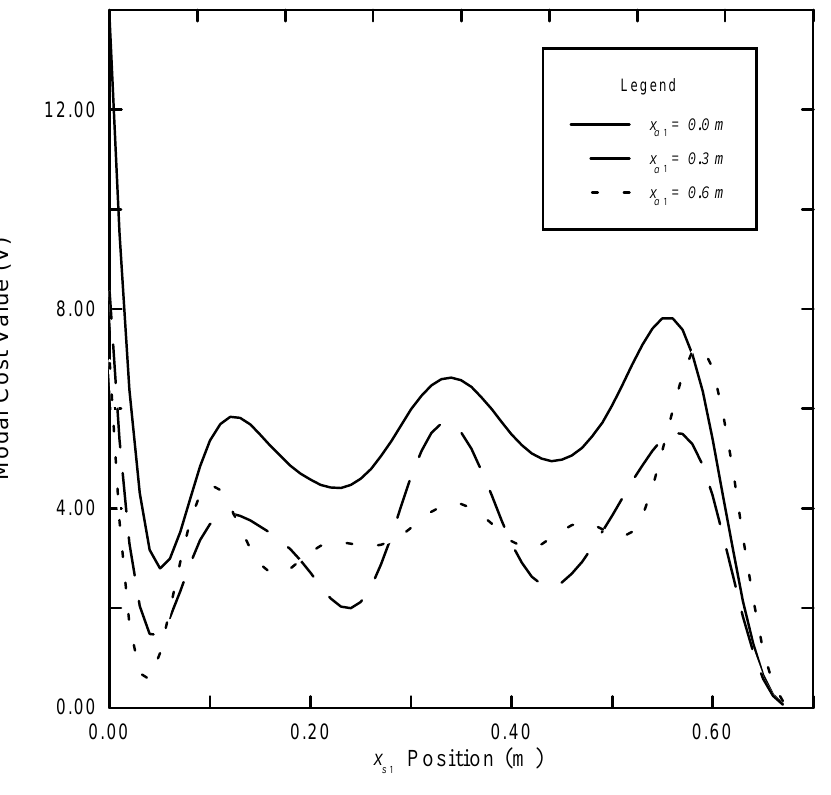
Fig. 4. Modal cost ( V ) versus sensor and actuator